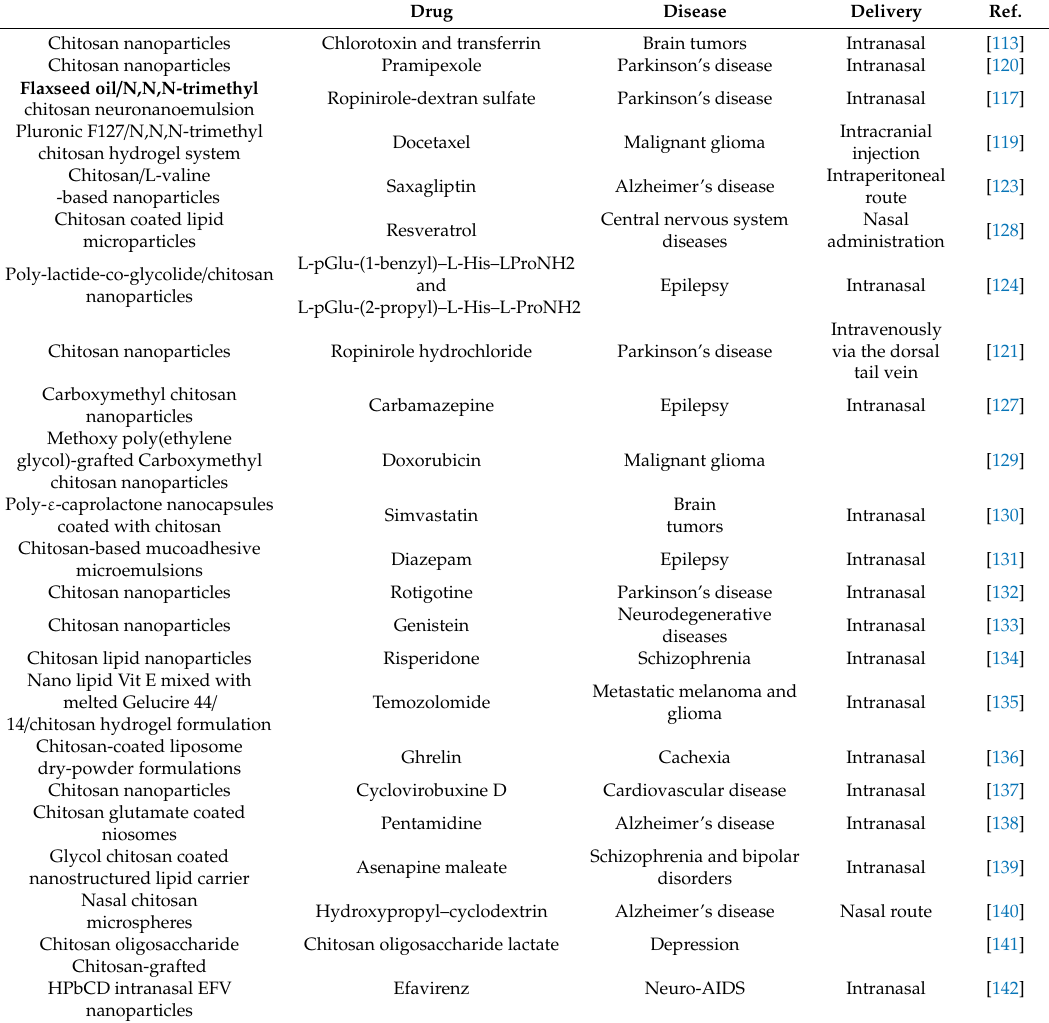
Table 5. Recent studies of chitosan formulations for brain uptake of di ff erent drugs. Drug Disease Delivery